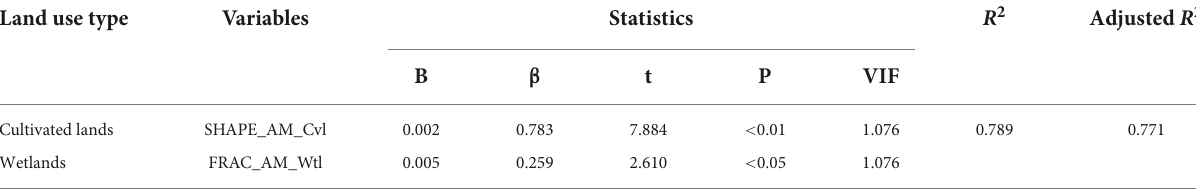
TABLE 6 Multiple regression analysis results obtained for the leading landscape patterns in the northern suburbs.